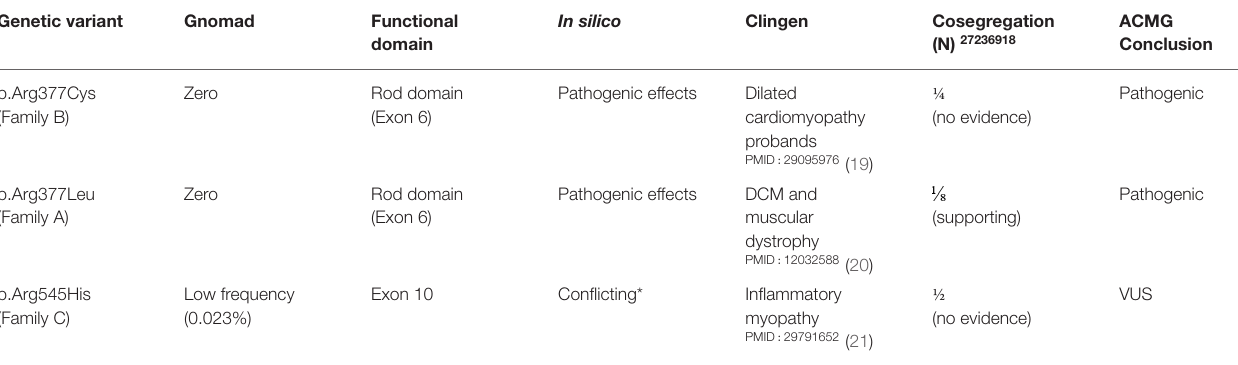
TABLE 1 | Detailed information of each genetic variant in the LMNA gene. Genetic variant